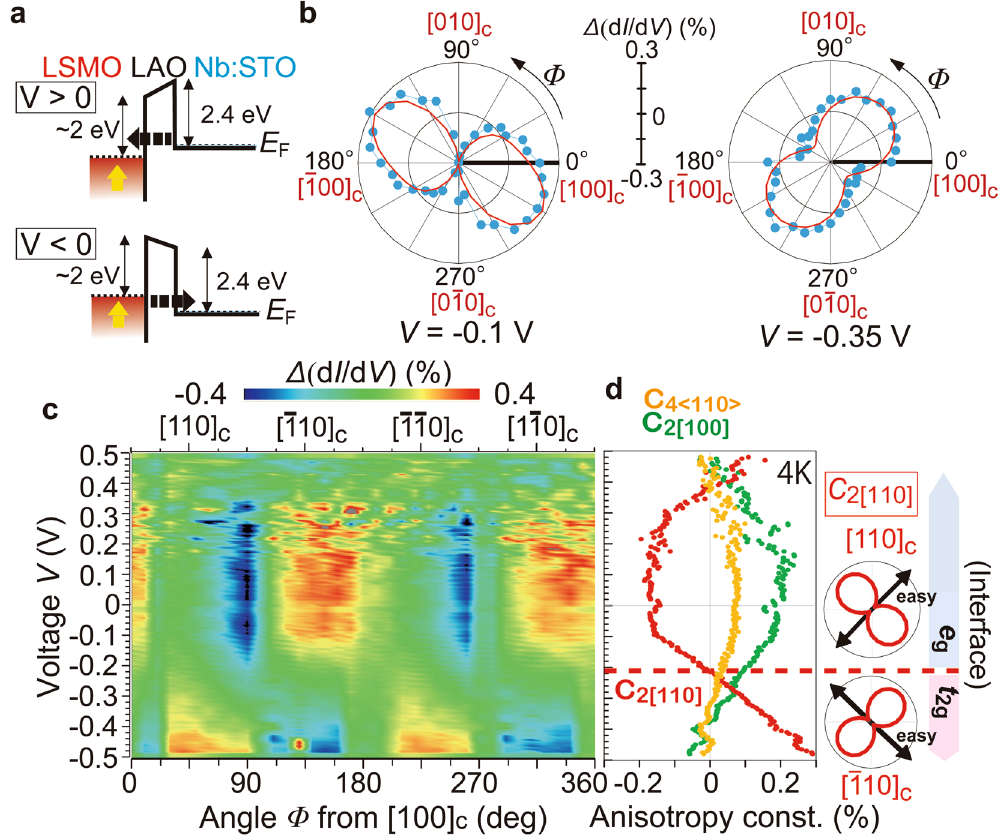
Figure 2. Tunneling anisotropic magnetoresistance results. ( a ) Conduction band (CB) profiles of the LSMO/ LAO/Nb:STO tunneling diode under positive and negative bias voltages V . The solid and dotted lines represent the top of the CB and the Fermi level E F . At positive (negative) V , the electrons tunnel from Nb:STO to LSMO (from LSMO to Nb:STO). ( b ) Polar plots of ∆ = V = − 0.1 and − 0.35 V (blue points). Here, Φ is the magnetic-field angle from the [100] c axis in the counter- clockwise direction in the film plane, and fitting curves. ( c ) Color plots of ∆ ( ) I components C 4[110] , C 2[100] , and C 2[110] . The sign of C 2[110] component changes at V = − 0.2 V, which corresponds to a 90° rotation of the easy magnetization axis of this component. This is attributed to the transition between the e g band and the t 2g band at the LSMO interface. In the right panel we illustrate the schematic ∆ ( ) I data and the easy magnetization axis of the C 2[110] component when V > − 0.2 V (top) and V < − 0.2 V (bottom). All the data were measured at 4